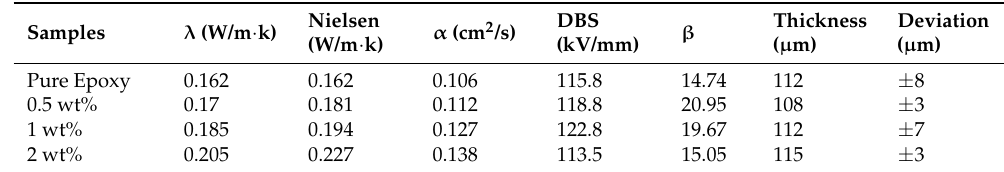
Table 1. Thermal diffusivity and dielectric breakdown strength of samples with different mass fraction of